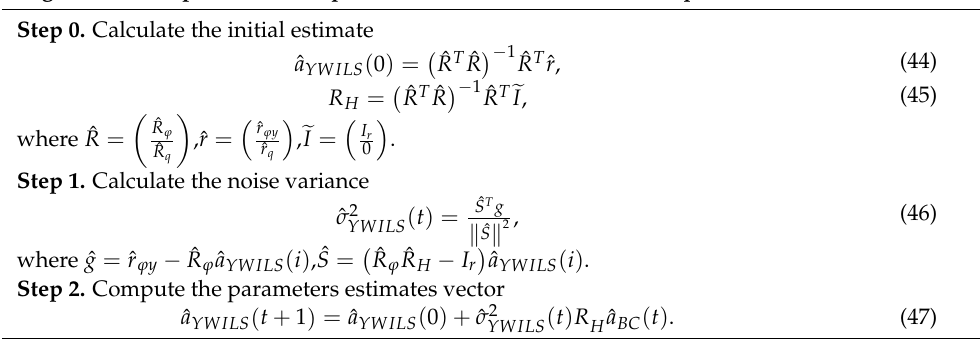
Algorithm 3. Improved least-squares based on the Yule-Walker equations (YWILS) [52]